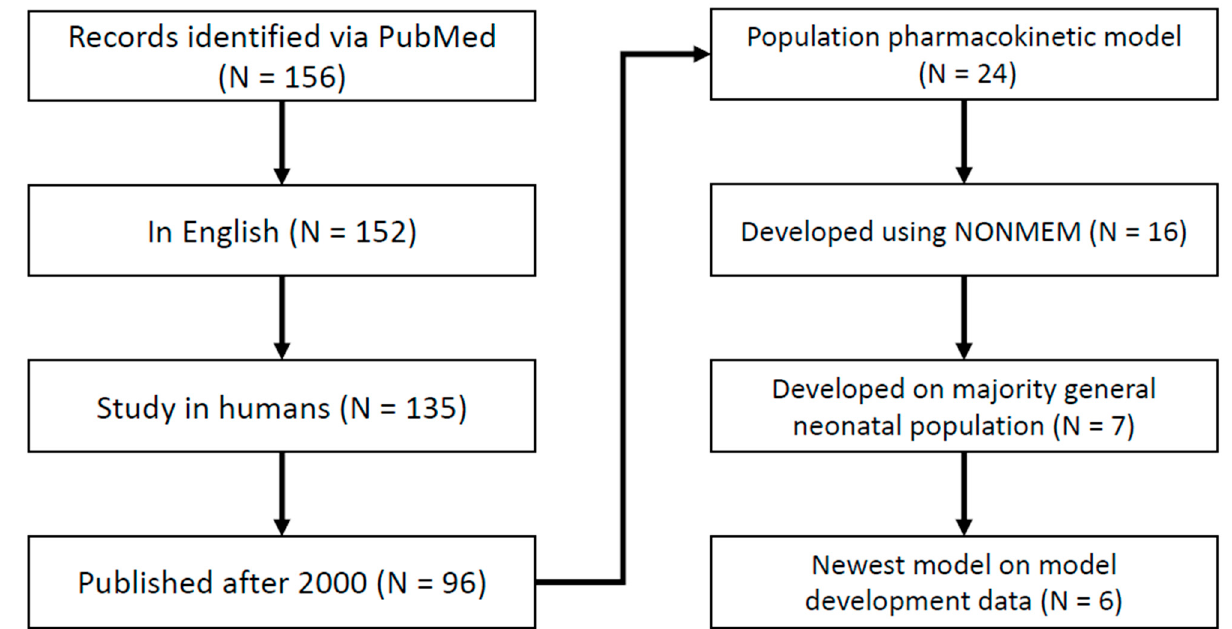
Figure 1. Diagram depicting the literature search for population pharmacokinetic models for gentam- icin in neonates in this study.